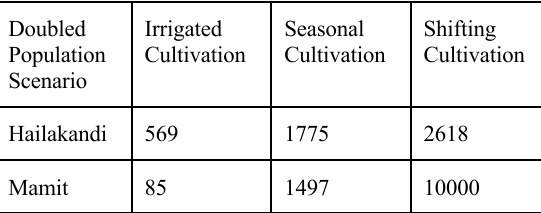
Table 8. Number of land parcels of 25 ha each under various forms of land use in the doubled population scenario for the